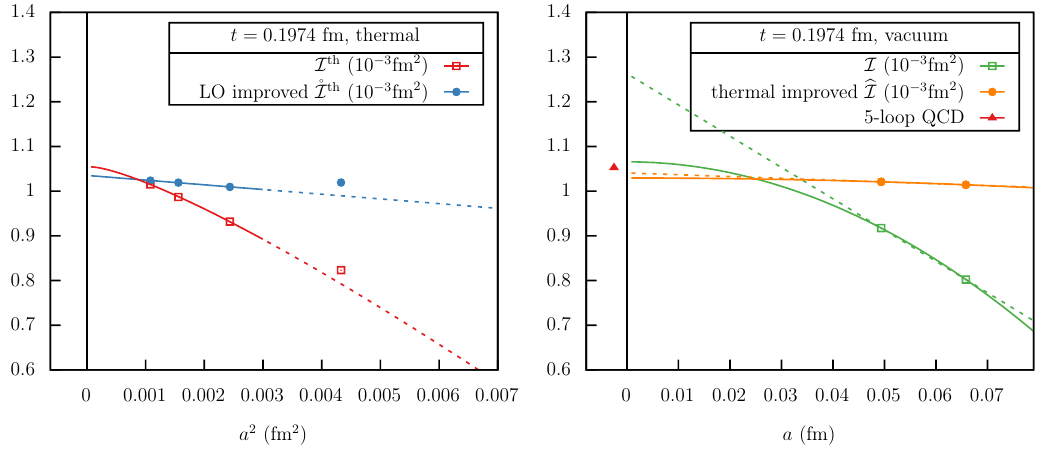
Figure 5 . Left: continuum limit for the truncated fourth moment of the thermal correlator, I th ( t = 0 . 1974 fm) . The open symbols represent the uncorrected observable, the corresponding curve showing the (Q+log) fit to the data points at the three finest lattice spacings. The filled symbols, the three leftmost of which are fitted linearly in a 2 , represent the leading-order improved observable. Right: continuum limit for the truncated fourth moment of the vacuum correlator, I ( t = 0 . 1974 fm) . The open symbols represent the straightforward estimator I ( t, a ) , while the filled ones represent the estimator b I ( t, a ) of eq. (2.11). Both data sets are fitted linearly either in a or in a 2 . We also estimated the observable I ( t ) using the perturbative five-loop vacuum spectral function, following refs. [24, 25], depicted with the red